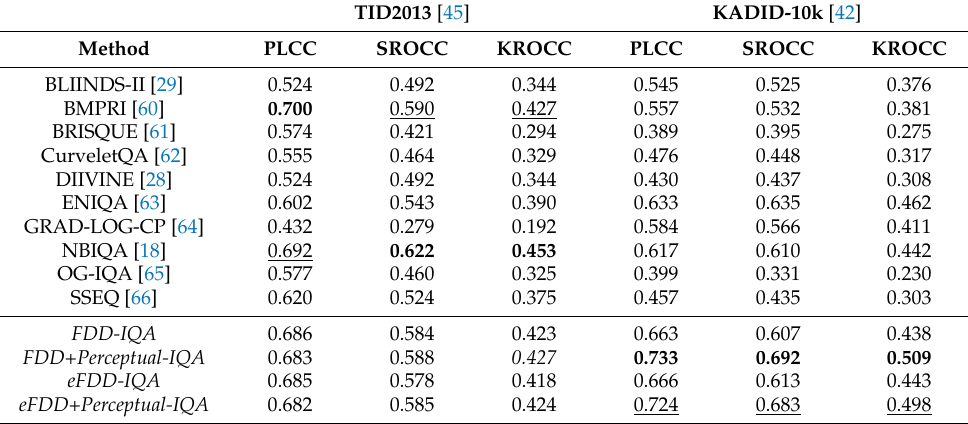
Table 10. Comparison of FDD-based NR-IQA methods to the state-of-the-art on artificial distortions (TID2013 [45] and KADID-10k [42]). Median PLCC, SROCC, and KROCC values were measured over 1000 random train–test splits. Best results are typed in bold, and second best results are underlined.